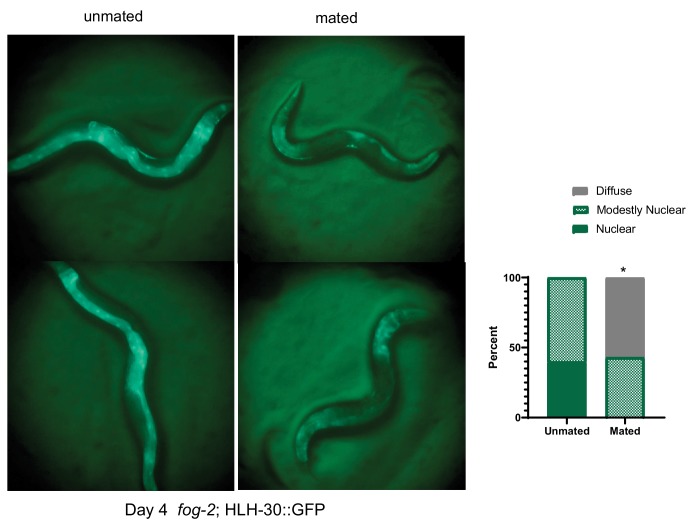
Mating also decreases nuclear HLH-30::GFP in fog-2 self-spermless hermaphrodites.Left: representative images of HLH-30::GFP in unmated and mated fog-2 hermaphrodites (Day 4). Quantitation of HLH-30::GFP in fog-2. (p=0.0328) Each worm was assigned a category based on HLH-30::GFP localization. Chi-square test was used to determine the significance.